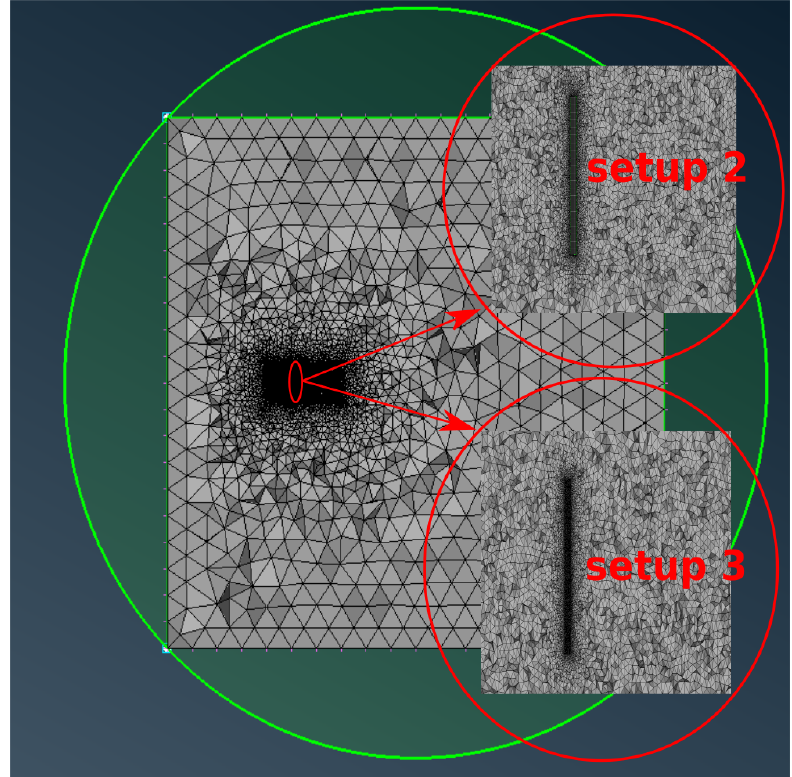
Figure 10. Wind turbine unstructured grid